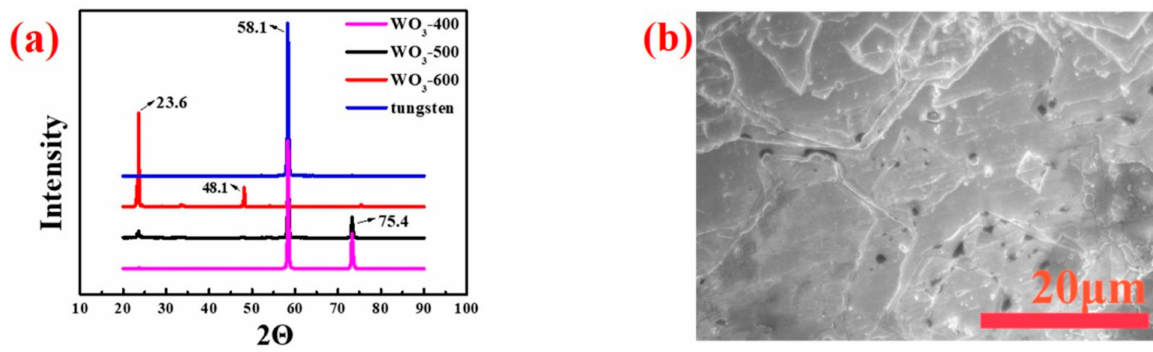
Figure 7. ( a ) XRD images of tungsten foil and tungsten oxide foil (WO 3 -X) calcined at different temperatures; ( b ) SEM images of tungsten